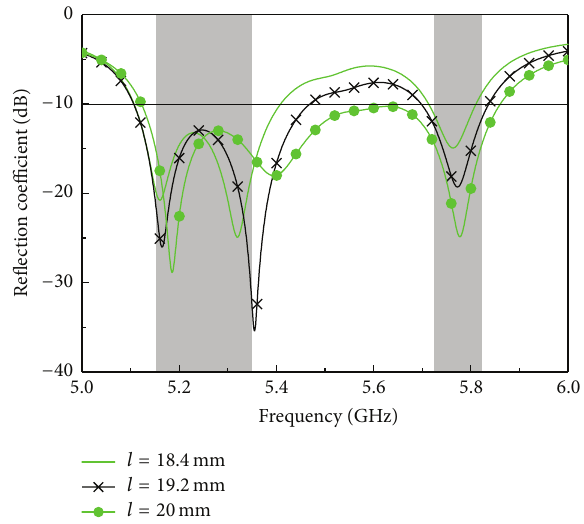
Figure 8: Simulated reflection coefficients for various values of length 𝑙 .